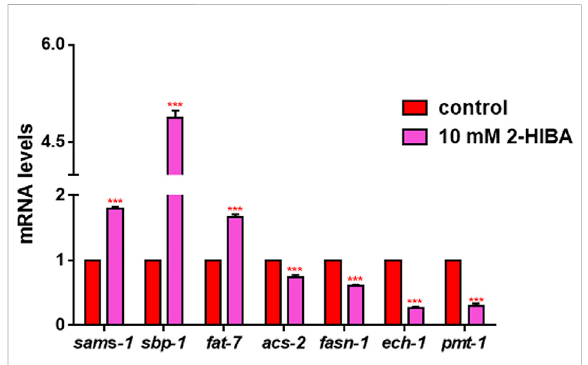
FIGURE 9 Real time-qPCR analysis of lipid metabolism genes in wild- type worms. Expression of genes involved in fat metabolism in 1 day adults treated or not with 10 mM 2-HIBA (control: untreated). Histograms show the expression of genes involved in lipid metabolism detected by real-time PCR. Experiments were performed in triplicate. Data are presented as mean ± SD (*** p <